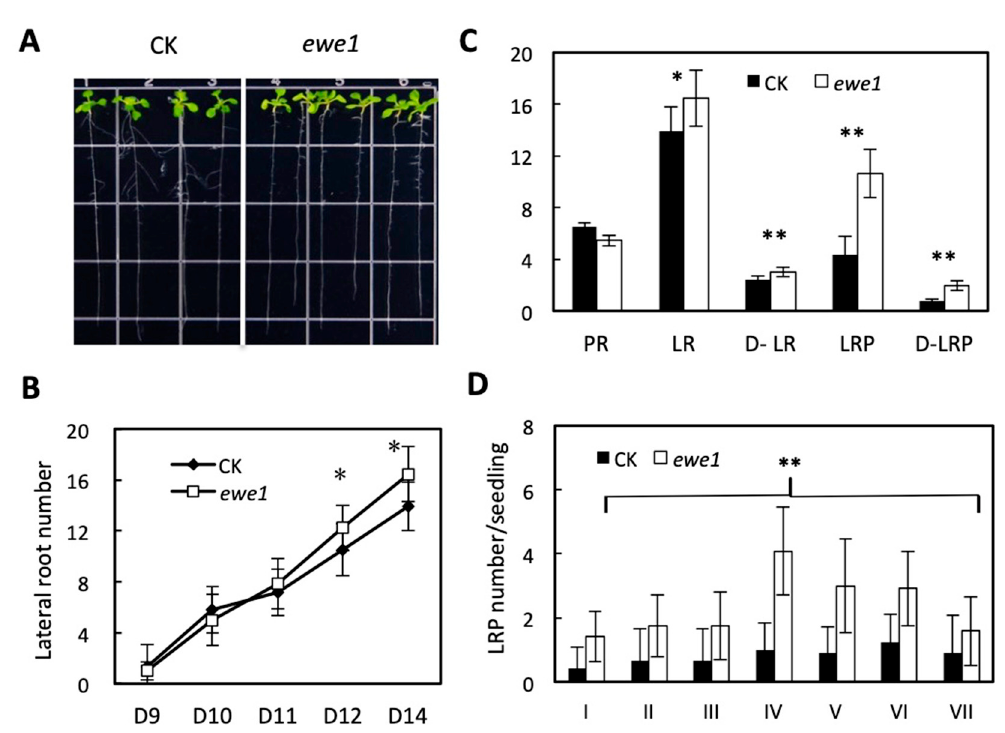
Figure 3. Characteristics of the ewe1 mutant. ( A ) The ewe1 mutant and its parental line, 12 days after germination. CK, the parent line containing the pWOX7pro::GFP reporter gene in wild type background (Columbia). ( B ) Lateral root number per seedling 9–14 days after germination. n = 14. ( C ) Primary root length (PR), lateral root number (LR), lateral root density (D-LR), number of lateral root primordia (LRP), and lateral root primordia density (D-LRP) 14 days after germination. n = 14. ( D ) Density of lateral root primordia at various developmental stages in 12-day-old seedlings. n = 14. The asterisks indicate degree of significance in the comparison, t -test, two-tailed. * p < 0.05, ** p <